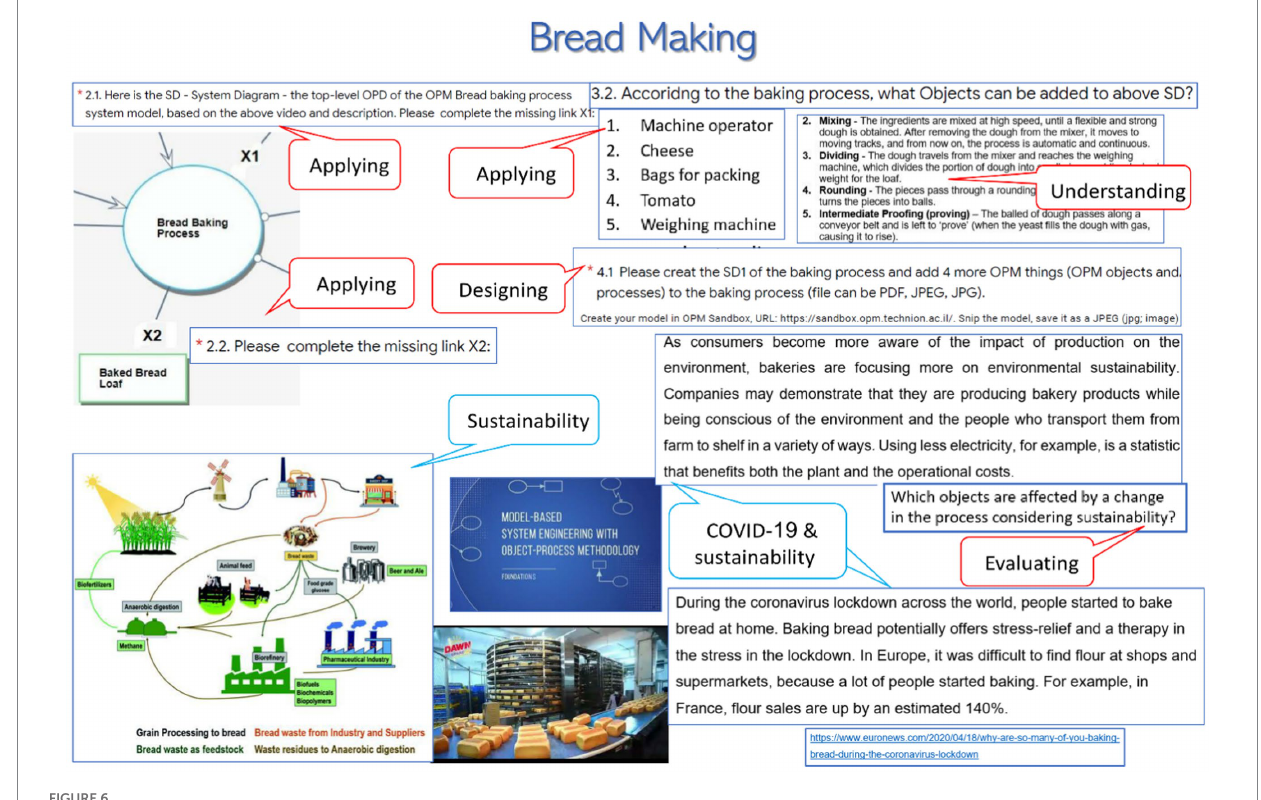
FIGURE 6 Selected segments from Romy’s bread making